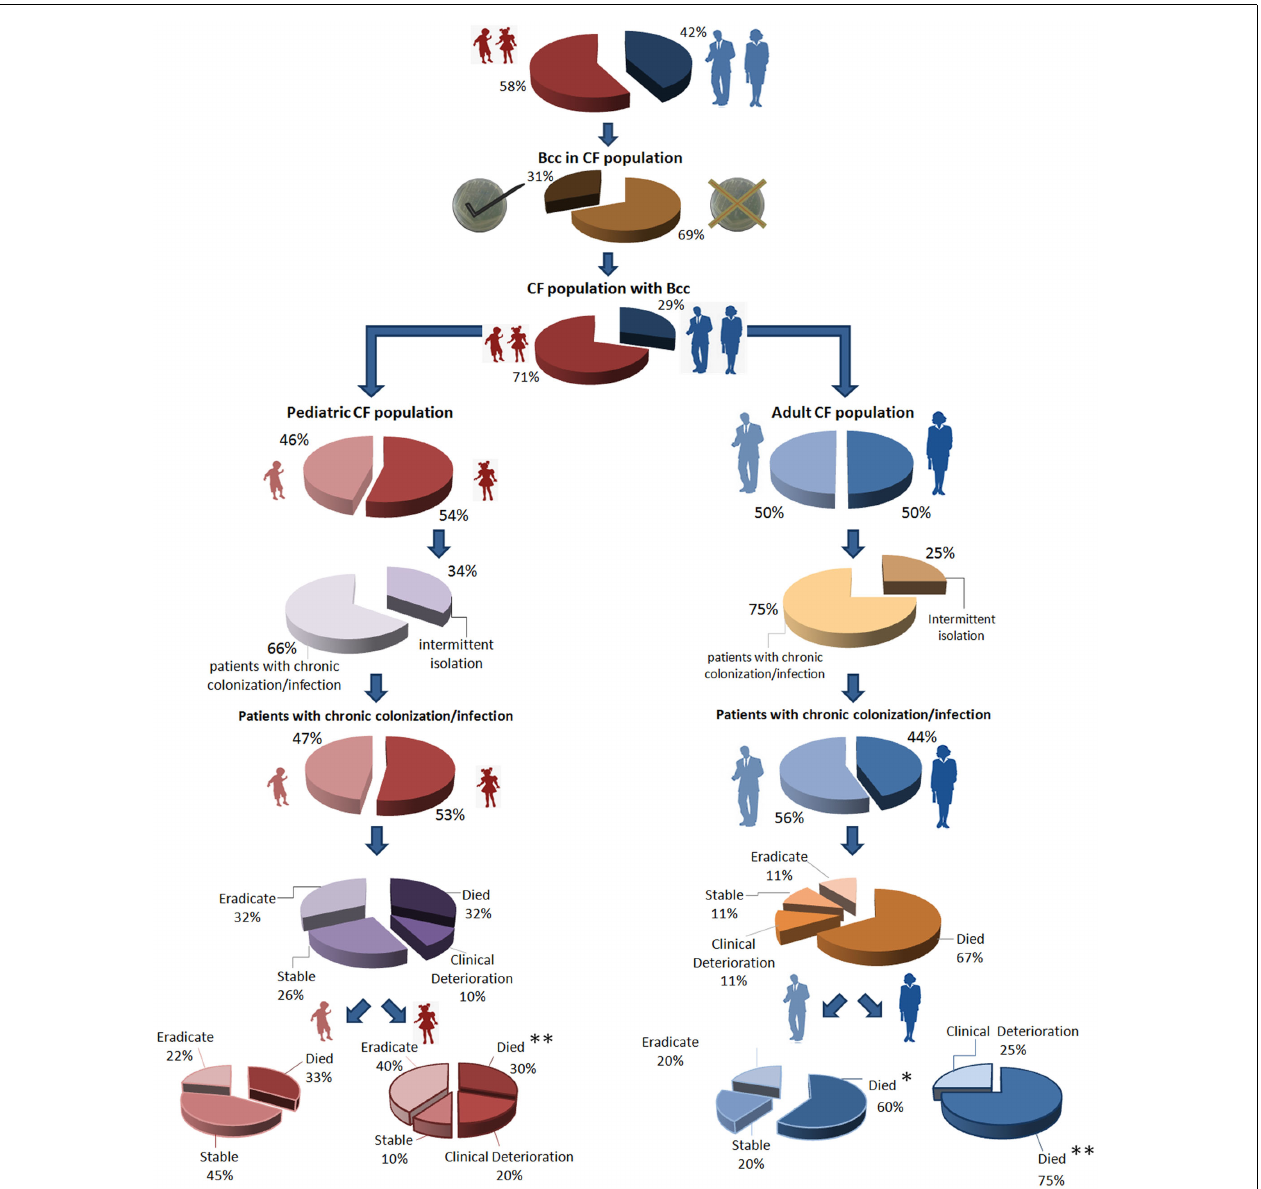
deceased patients, at least five had developed the cepacia syndrome at the time of death (each patient marked as ∗ ). Based on the information published in Richau et al. (2000), Cunha et al. (2003, 2007), and on other recent unpublished